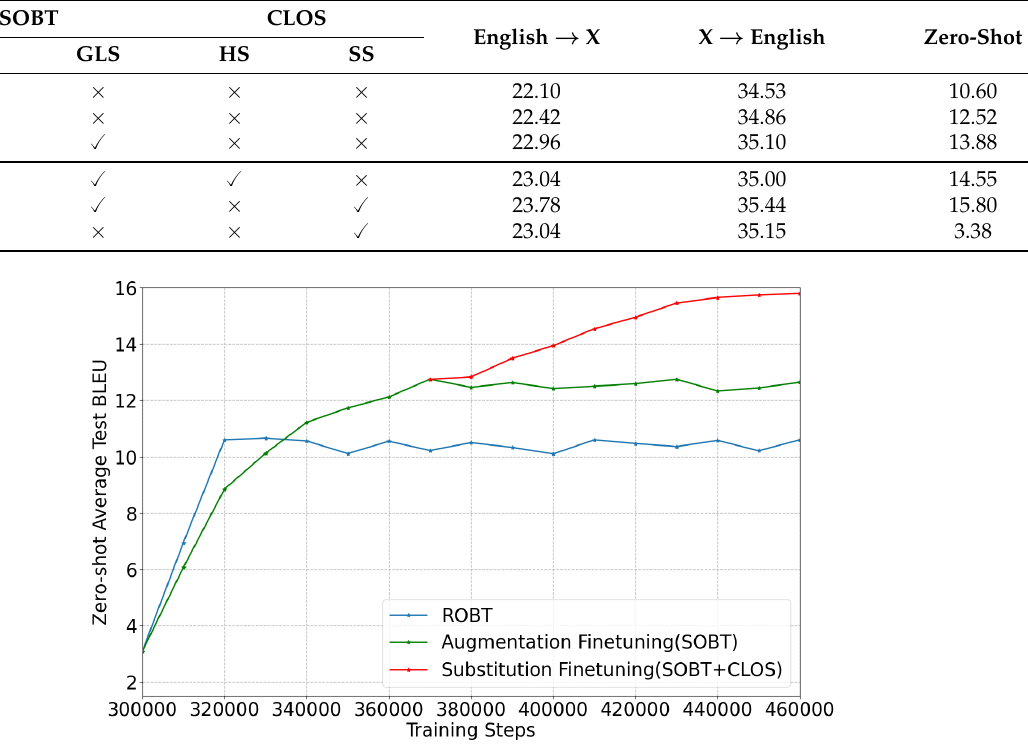
Table 5. Ablation study based on the OPUS-100 dataset. Evaluations are performed with BLEU metric. We compare the transformer-base model performances with different combinations of SOBT(BLS), SOBT(GLS), CLOS(HS), and CLOS(SS). BLS denotes batch-level selection criterion, GLS denotes global-level selection criterion, HS denotes hard substitution, SS denotes soft substitution.